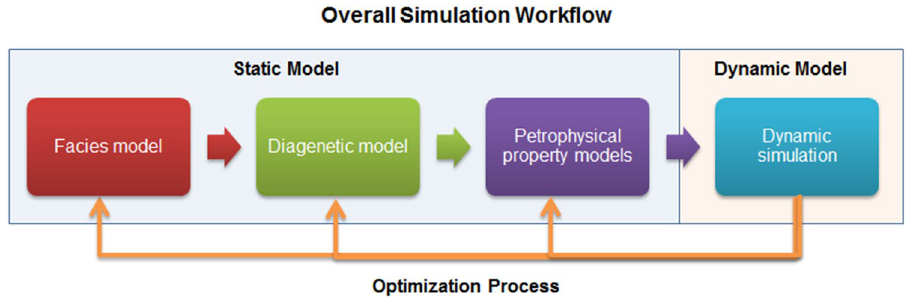
Fig. 1 Overall simulation workflow. Optimization can be applied to calibrate the param- eters involved in any of the dif- ferent blocks of the simulation